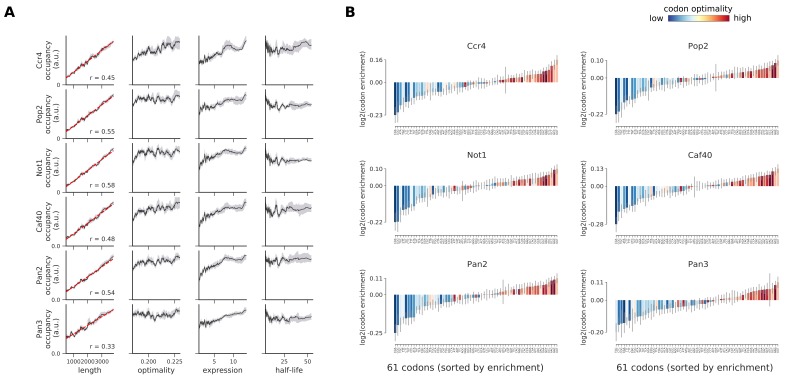
Occupancies of deadenylation factors (Ccr4, Pop2, Not1, Caf40, Pan2, and Pan3) compared to transcript length, optimality, expression level, and half-life.(A) To understand binding specificity of deadenylation factors, the total occupancy of each factor on a transcript is plotted against various transcript features (Gray shading: 95% confidence intervals generated by bootstrapping transcripts). (B) Same analysis as in Figure 6B: Codon enrichment shows deviations in codon frequencies of transcripts bound by a degradation factor compared to each codon’s frequency on all coding sequences. Each bar is colored according to its codon-optimality with highly optimal codons in dark red and highly non-optimal codons in dark blue. (Gray lines: 90% confidence intervals generated by bootstrapping coding sequences).